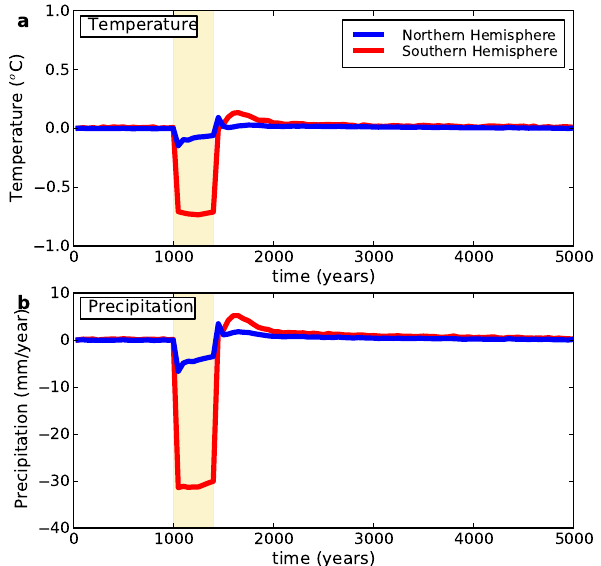
Fig. 19. Evolution of (a) air temperature ( ◦ C) and (b) precipitation (mmyr − 1 ) in the Northern (blue) and Southern (red) Hemispheres for the simulation during the Preindustrial with a fresh water flux added in the southern part of the Atlantic of 0.5Sv during 400 yr.